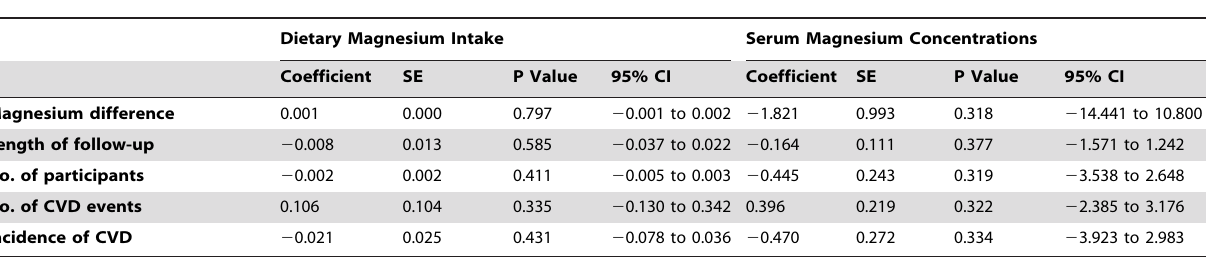
Table 5. Meta-regression